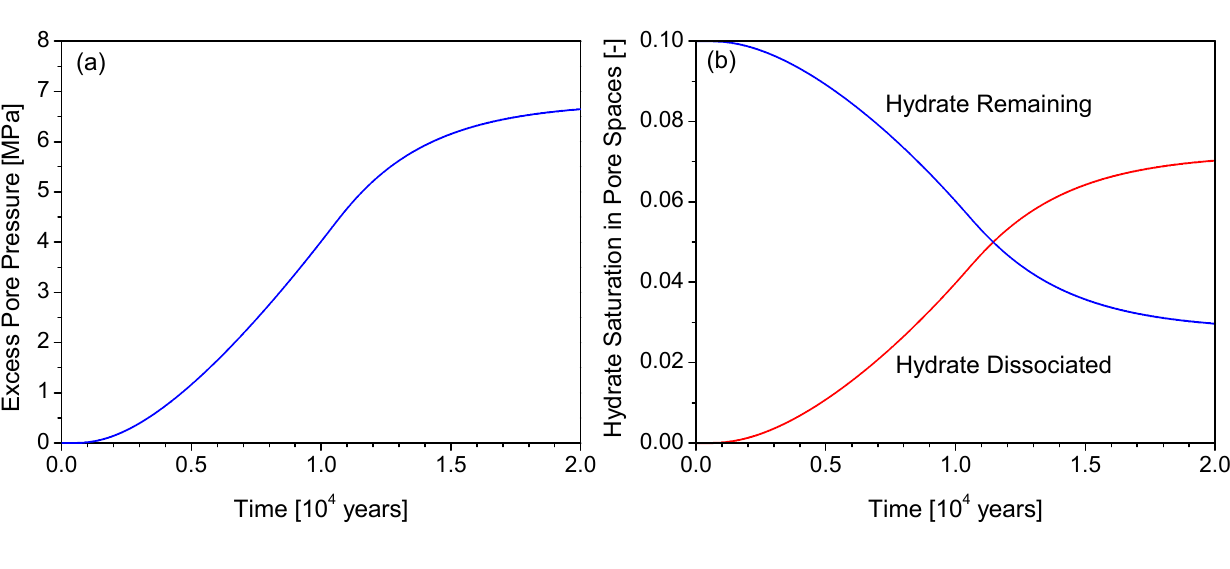
Figure 5. Isochoric destabilization of methane hydrate at BHOZ: ( a ) excess pore pressure developed and ( b ) volume fractions of remaining and dissociated hydrates corresponding to temperature increase.